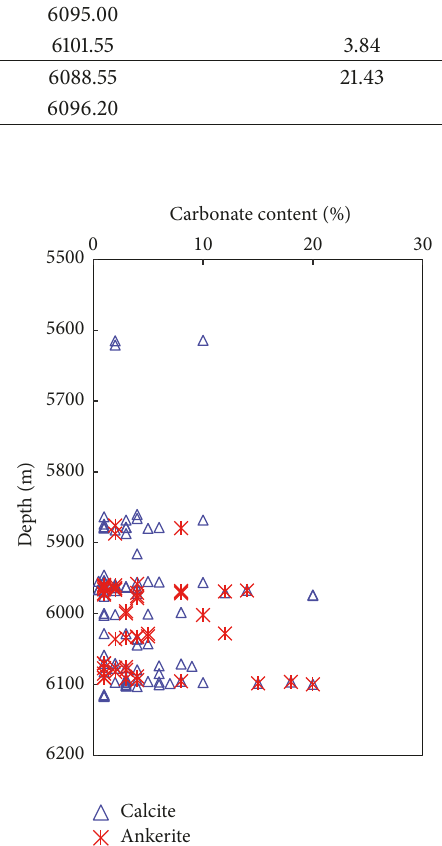
Figure 6: Regional abundance of carbonate cements versus depth in the Jurassic Formation. Text data from 125 core samples show that carbonate is abundant from below 5800 m and increases with depth down to about 6100m burial depth. The contents of calcite have little changes with the depth. However, ankerite has a sharp interface of 5850 m burial depth and the content increases with the depth.